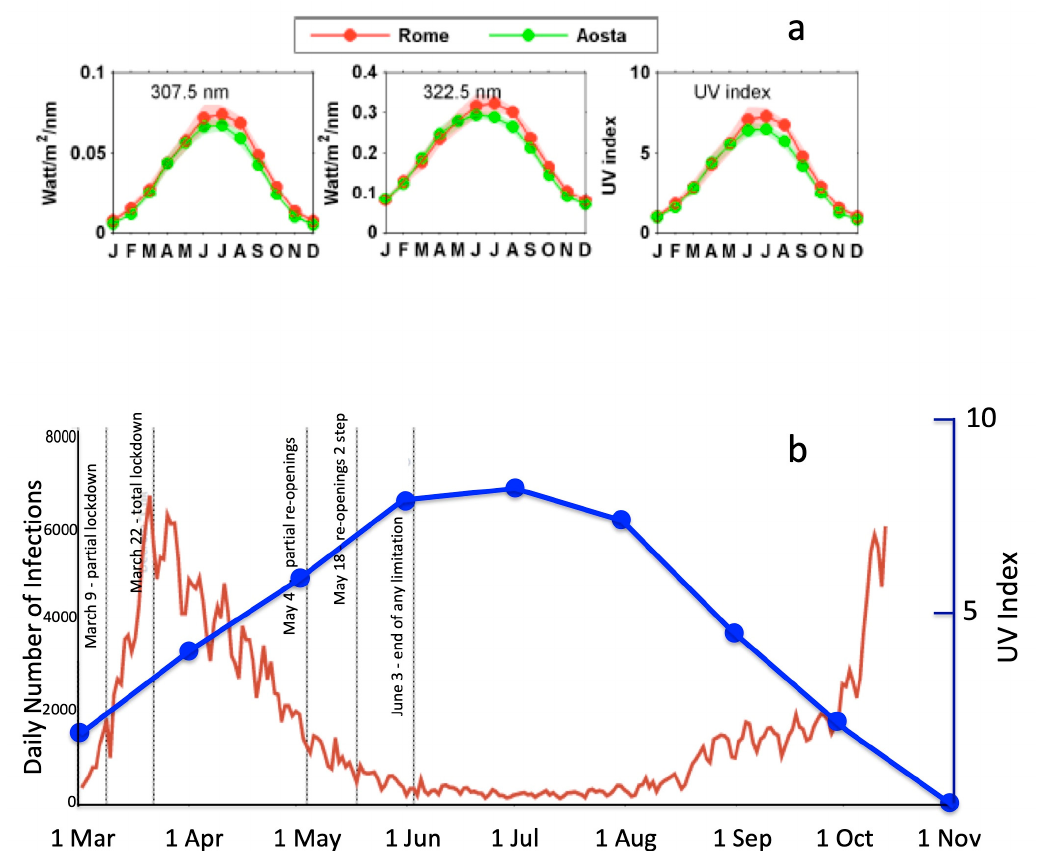
Figure 3. ( a ) From left to right: climatologies of the irradiance at 307.5 nm, 322.5 nm, and the UV index at two stations in Italy: Aosta, Northern Italy, Rome, Central Italy, in the period 2006–2015. Shaded intervals correspond to the standard deviation of the climatological values and the average ratios (redrawn from [24]). ( b ) Comparison of the official daily infection curve in Italy from March 1st to mid-October (red line) with the average (2006–2015) UV intensity curve recorded at Rome station.